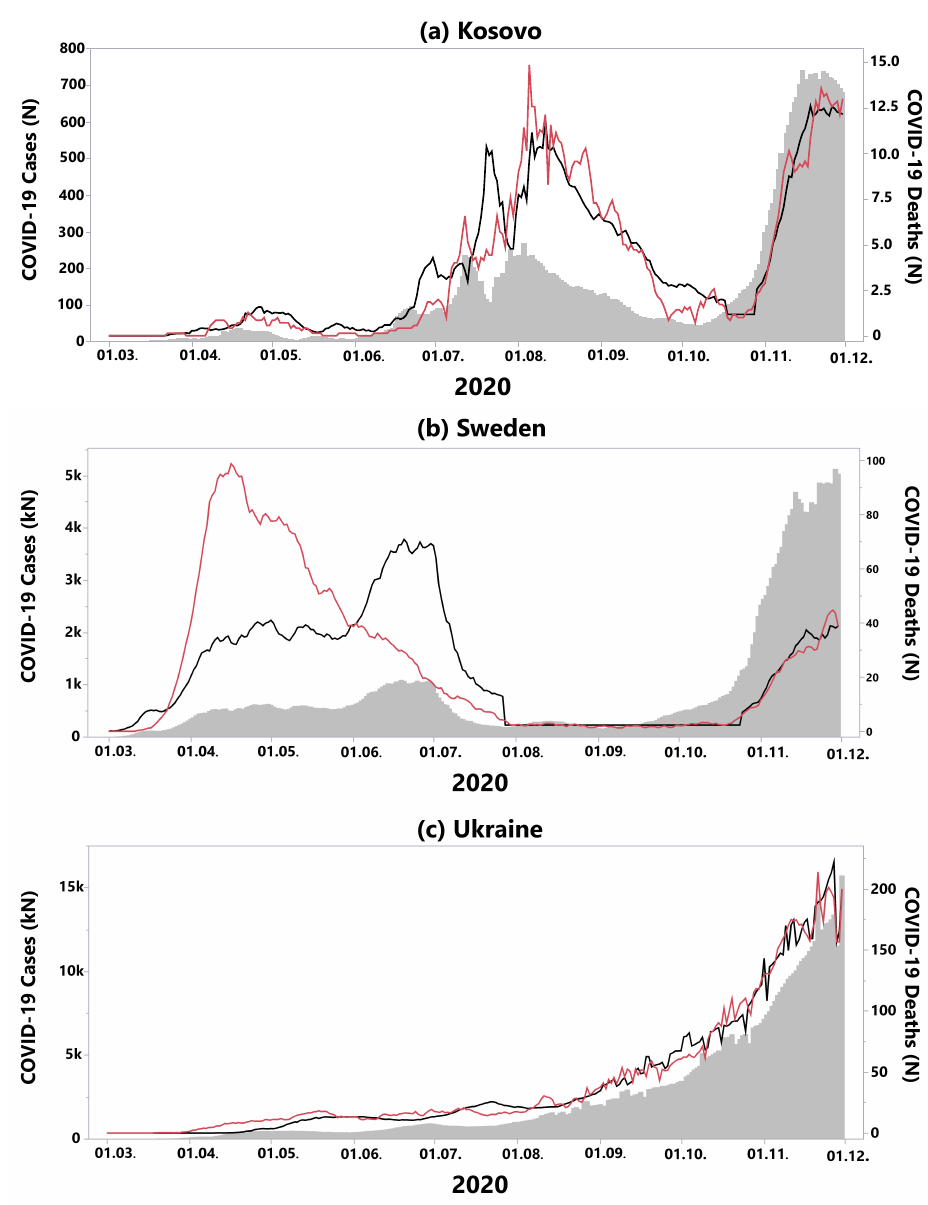
Figure 4. Countries where the three-phase-model was not applicable. ( a ) In Kosovo, the second phase with a relative low death rate was missing. Instead, the country suffered a second wave during summer, directly followed by a third wave. ( b ) In Sweden, at the beginning of the first wave, the recorded death rate was much higher than predicted by the incidences. In the second wave, the model fitted the data well, with a cCFR of α 2 = 0.8%. ( c ) In Ukraine, there were no waves; instead, COVID-19 incidences and related deaths increased constantly over the course of the year